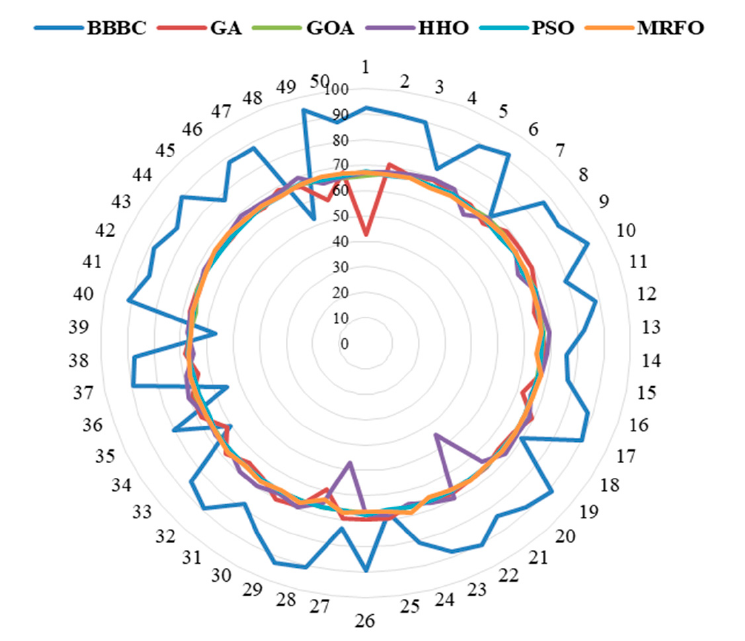
Figure 12. The REF vs. runs using MRFO compared to the other five algorithms for LPSP = 0%.